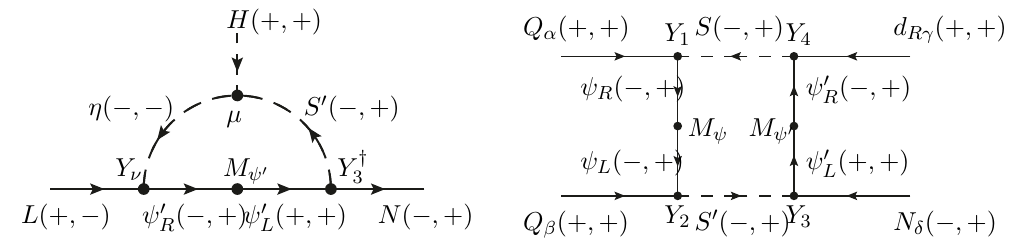
Figure 1 . Diagrams for the Dirac neutrino mass and the d = 6 proton decay operator. The signs +/ (cid:0) represent the charges under the ( Z ( A ) term M 0 of the fermion (cid:12)eld 0 , and Z ( B )